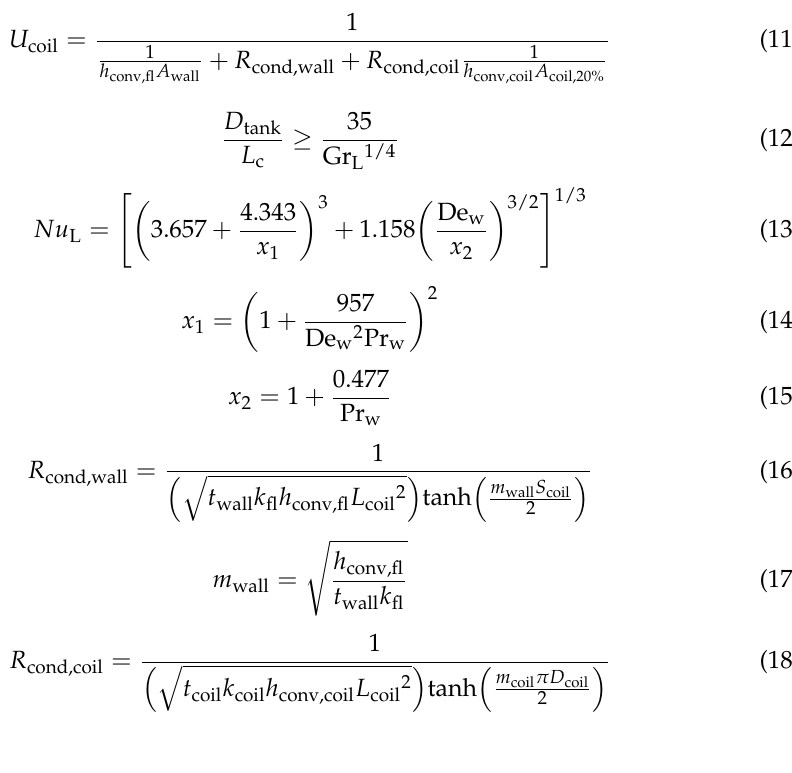
Figure 10. Heat-transfer direction from the water inside the coil heater to the fluid inside the tank.